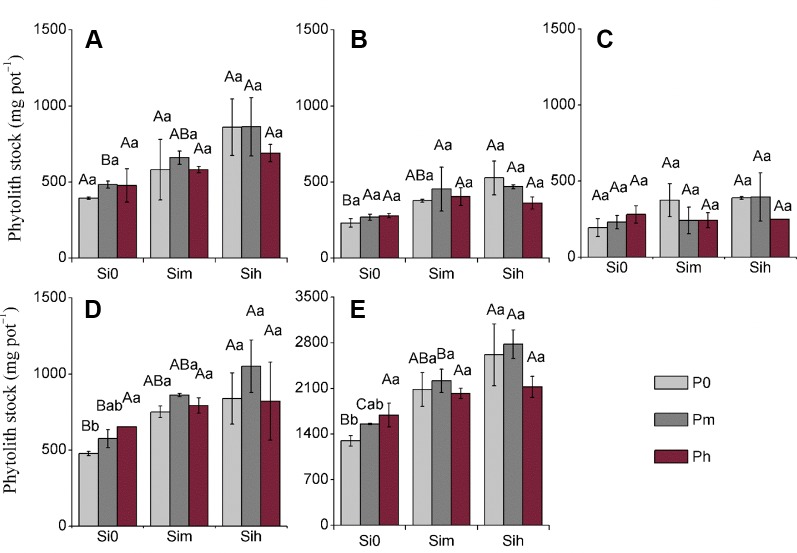
Phytolith stock (mg pot−1) at a two-way analysis of variance of silicon-phosphorus (Si-P) levels in the different plant parts. (A) Leaf; (B) flag leaf; (C): stem; (D): sheath; (E) rice shoot. Error bars represent the standard deviations of the means. Different lowercase letters indicate significant differences among the treatments in different P treatments and rice plant parts at a given Si level, respectively [least significant difference (LSD) test; p ≤ 0.05, n = 5]. Different uppercase letters indicate significant differences among the treatments in different Si treatments and rice plant parts at a given P level, respectively (LSD test; p ≤ 0.05, n = 5).